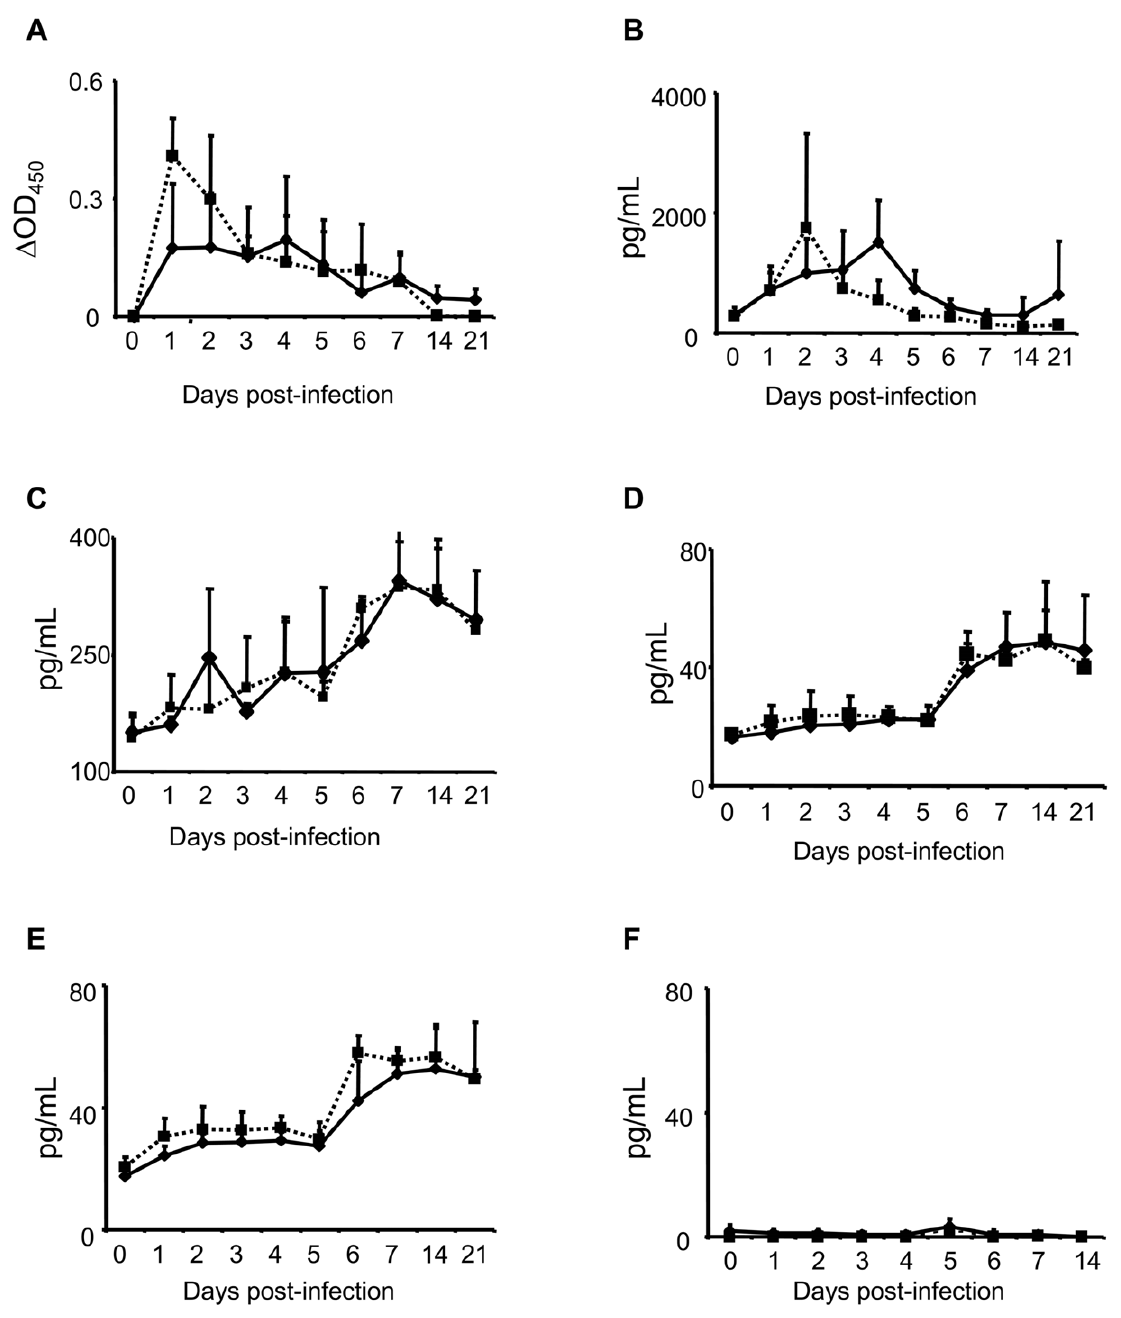
Figure 5. Serum cytokine response in RVFV-infected goats. A: Interleukin (IL)-12, B: interferon gamma, C: Tumour necrosis factor alpha, D: IL-6 and E: IL-1 b and F: interferon alpha. — & — IN-RVFV and — ¤ —MAM RVFV- infected goats (n=4 goats each). Data points represent means + standard deviation. MAM-RVFV=RVFV produced in the mammalian cell line Vero E6, IN-RVFV=RVFV produced in the insect cell line C6/36.